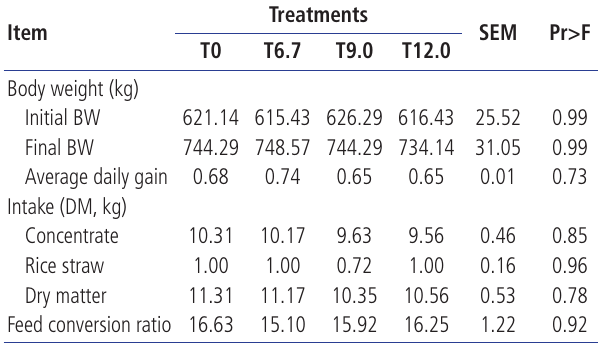
Table 2. Effects of dietary levels of tapioca residue on growth performance in late fattening Hanwoo steers Item